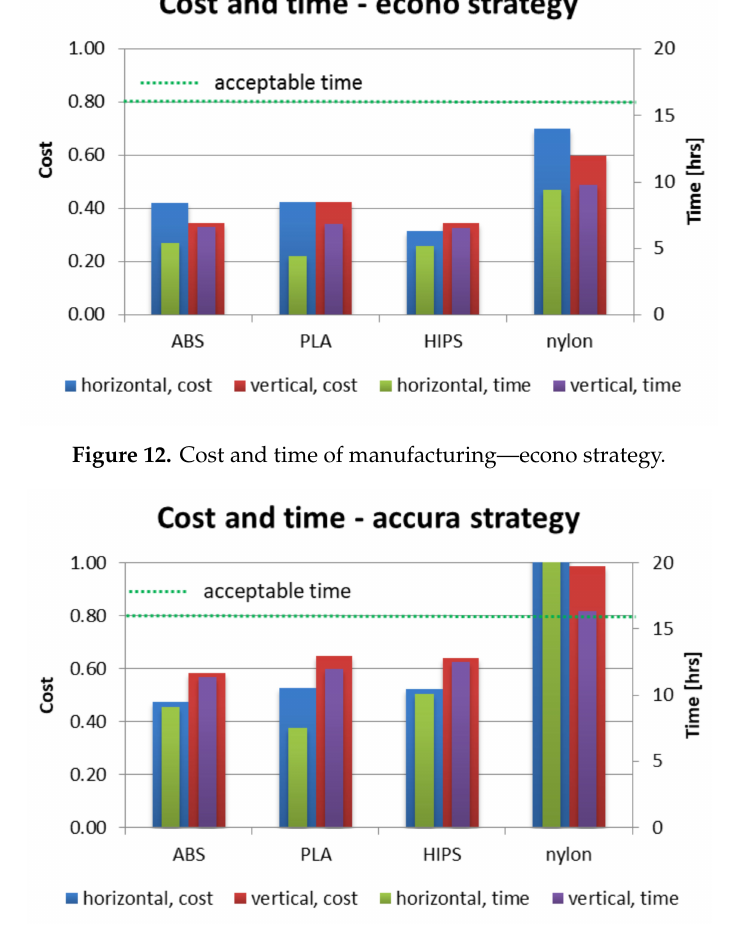
Figure 13. Cost and time of manufacturing—accura strategy.